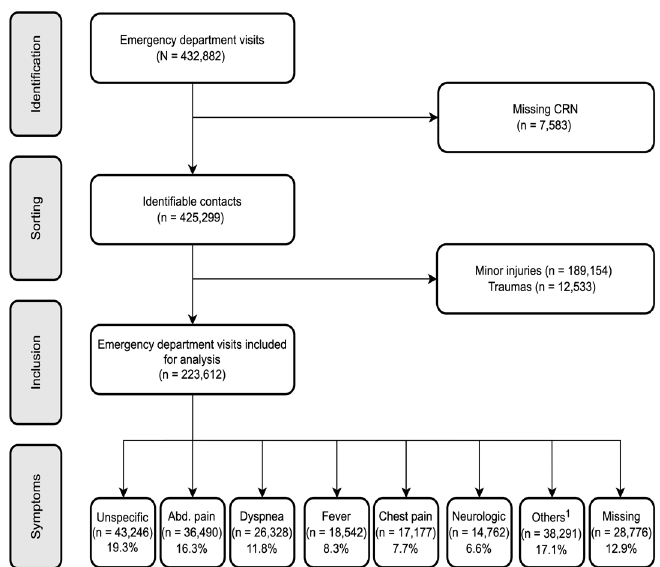
Figure 1. Flow diagram of the selection of adult non-trauma emergency department patients arriving at a hospital in the Region of Southern Denmark between 2016-2018, and the distribution of patients according to the most frequent chief symptoms at arrival.